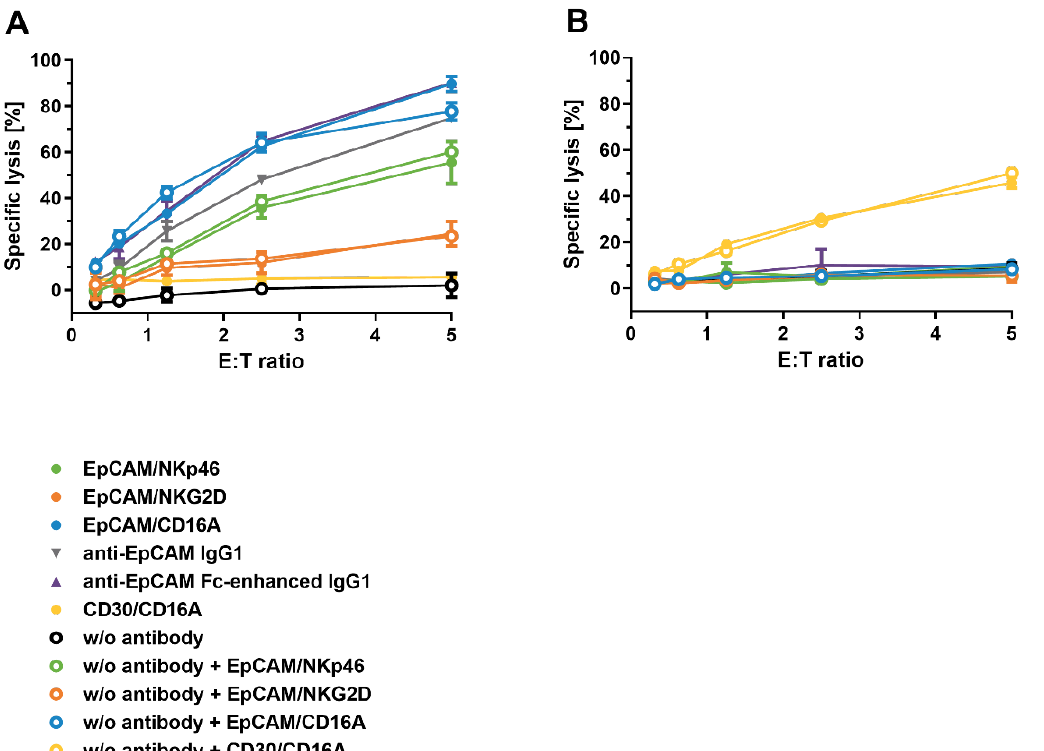
Figure 8. Cytotoxicity of cryopreserved NK cells pre-complexed with ICE ® constructs against HCC-1187 and KARPAS-299 target cells. NK cells as effector cells were pre-complexed with 10 µ g/mL of the indicated ICE ®® constructs and antibodies and frozen at − 80 ◦ C. As control samples, aliquots of the same NK cells were pre-incubated without an antibody (w/o antibody) and subjected to one freeze/thaw cycle. Thawed NK cells were washed and directly used as effector cells at the indicated E:T ratios. Where indicated, ICE ® constructs (EpCAM/NKp46, EpCAM/NKG2D, EpCAM/CD16A, or CD30/CD16A) were freshly added to NK cells that were not pre-complexed at a concentration of 10 µ g/mL to the cytotoxicity assays against HCC-1187 ( A ) and KARPAS-299 ( B ) target cells. The mean ± standard deviation of duplicate lysis values were plotted. E:T, effector-cell-to-target-cell ratio; w/o, without. Table 8. Efficacy of cryopreserved and revived ICE ® constructs pre-complexed with NK cells.